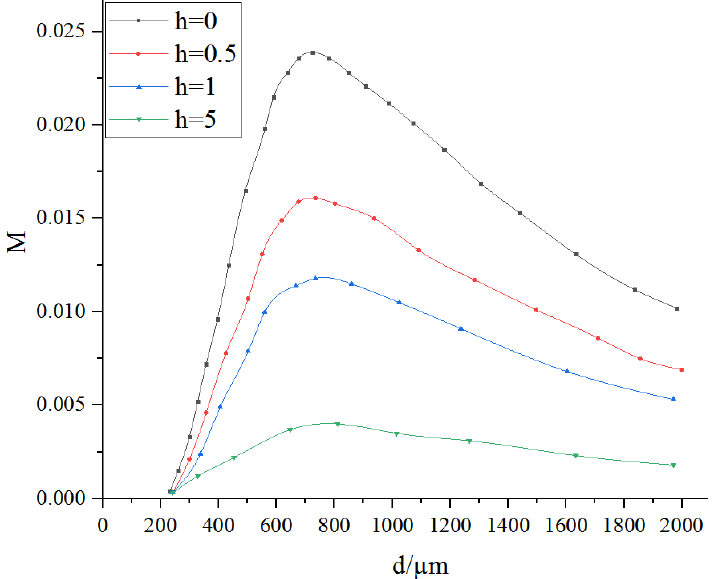
Fig. 2 Influence of reflector roughness on modulation